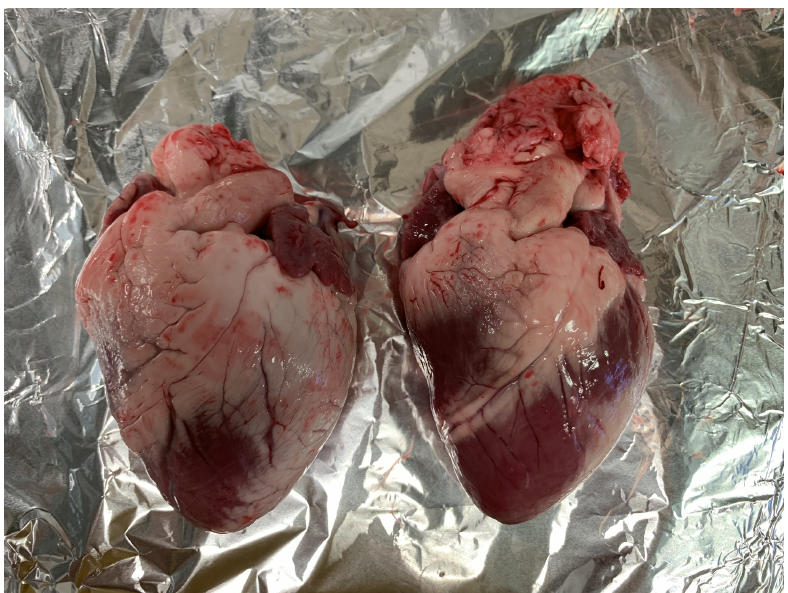
Figure 2. Two heart samples from A1 (left) and A2 (right). The hearts are different in size, shape and the amount of pericardial fat covering the epicardium. The pericardial fat extends around the whole heart presenting a challenge when measuring the dielectric properties of the tissues on the exterior